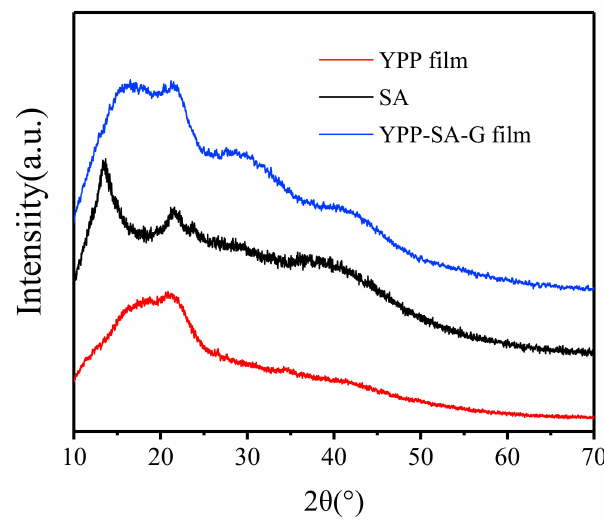
Figure 5. XRD patterns of various film and component.